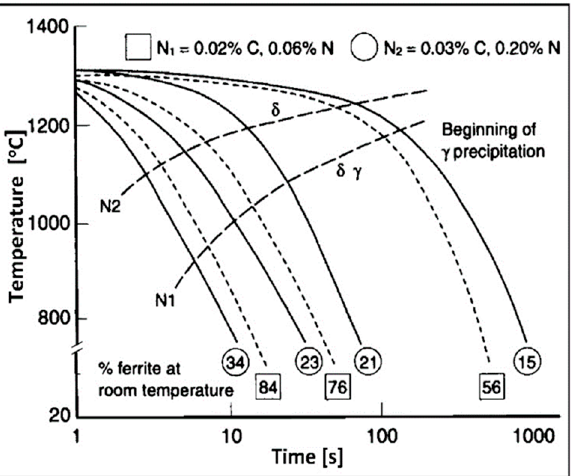
Figure 9. TTT diagram for DSS 25% Cr duplex steels with different alloyed nitrogen content (according to [28]).